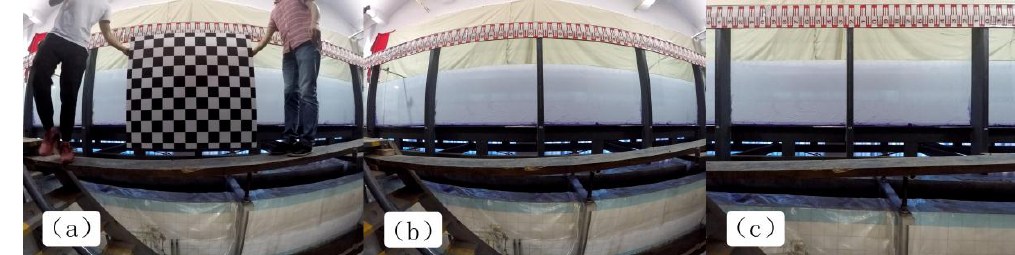
Figure 2. Picture calibration: ( a ) calibration board; ( b ) original image; ( c ) calibrated image.